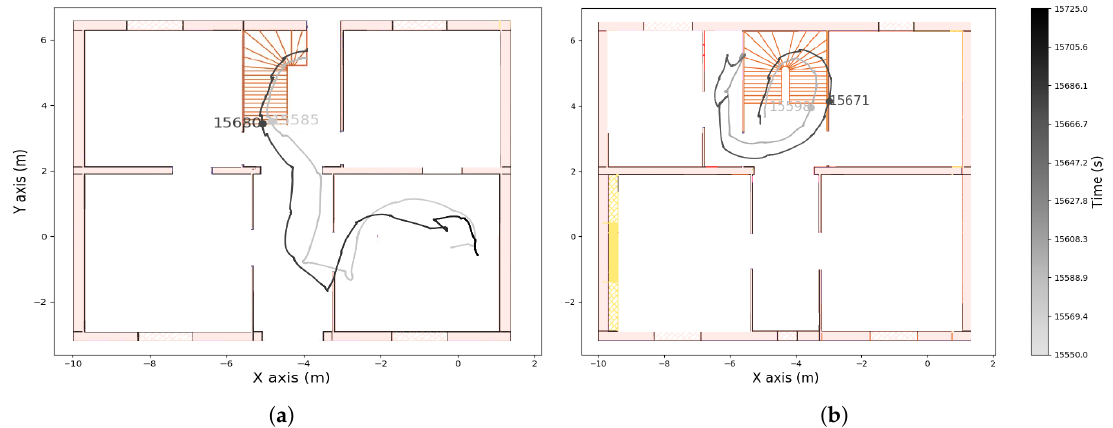
Figure 11. Computed trajectory during the third walking period on ( a ) the ground floor and ( b ) the first